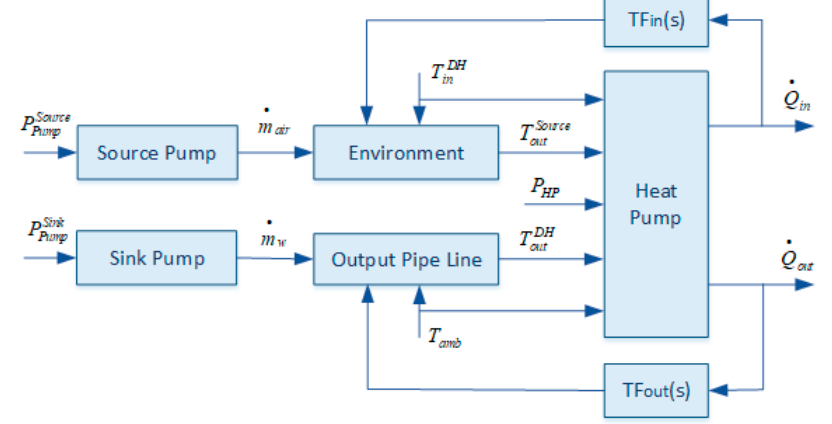
Figure 10. Detailed block diagram of the considered heat pump (HP) unit.